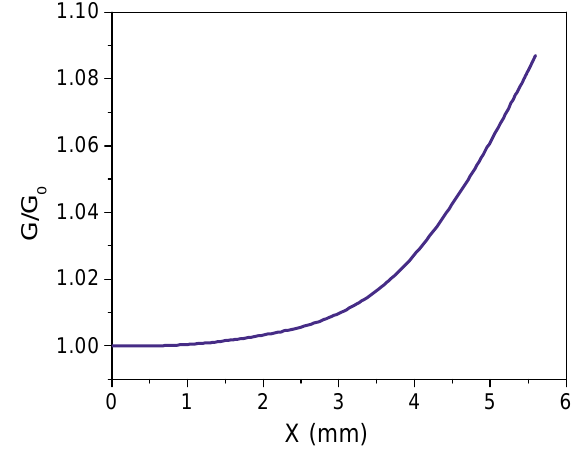
FIG. 13. (Color) Gradient of the electric field as a function of transverse